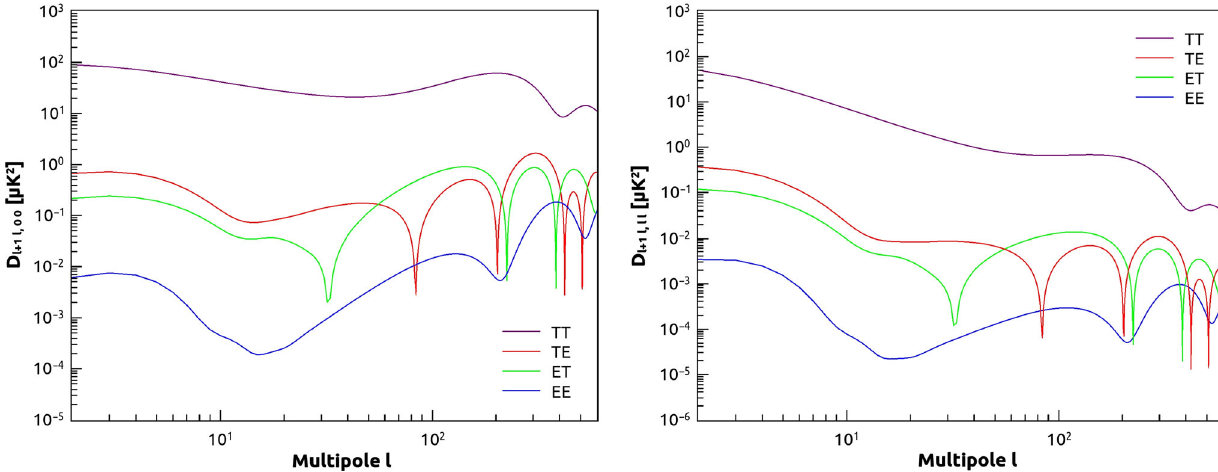
Fig. 1 The anisotropic TT , T E , ET , EE correlation coefficients for m = 0 ( left panel ) and m = l ( right panel